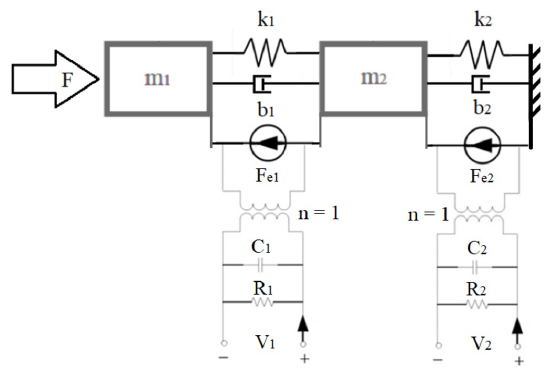
Figure 14. Piezoelectric equivalent model of the considered syn- thesized